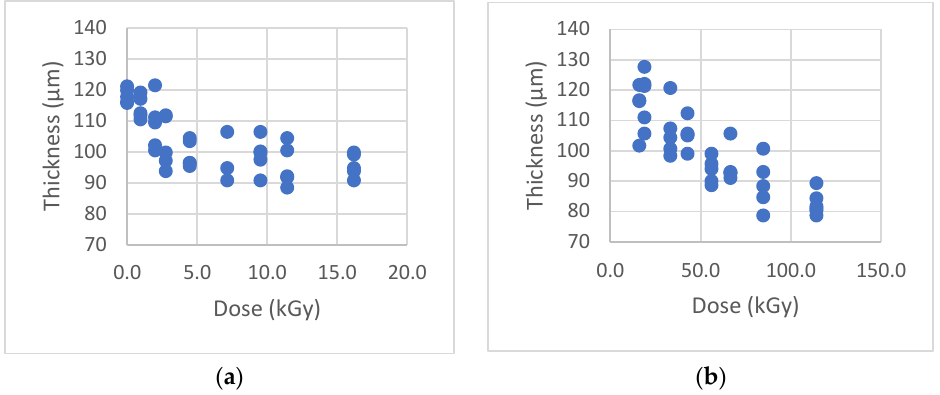
Figure 18. Thickness of the samples for porosity measurements: ( a ) Dose range 0 – 16 kGy; ( b ) Dose range 16 – 114 kGy.